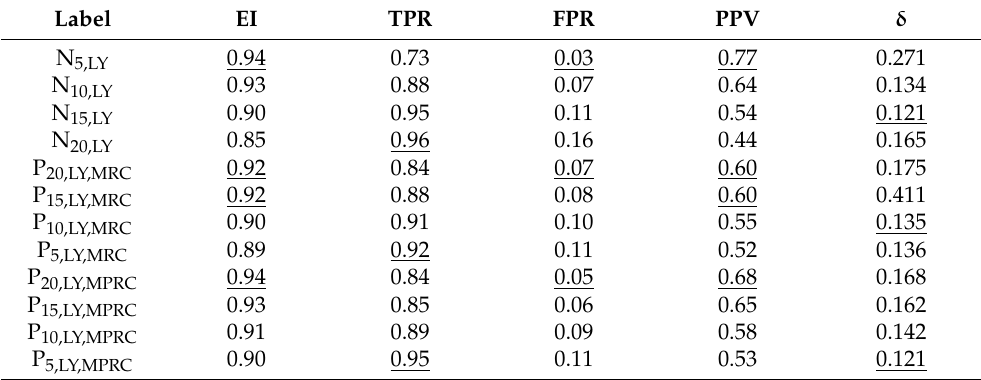
Table 8. Skill scores for the defined rainfall thresholds in LY (the best values of the scores, for each type of threshold, are underlined).